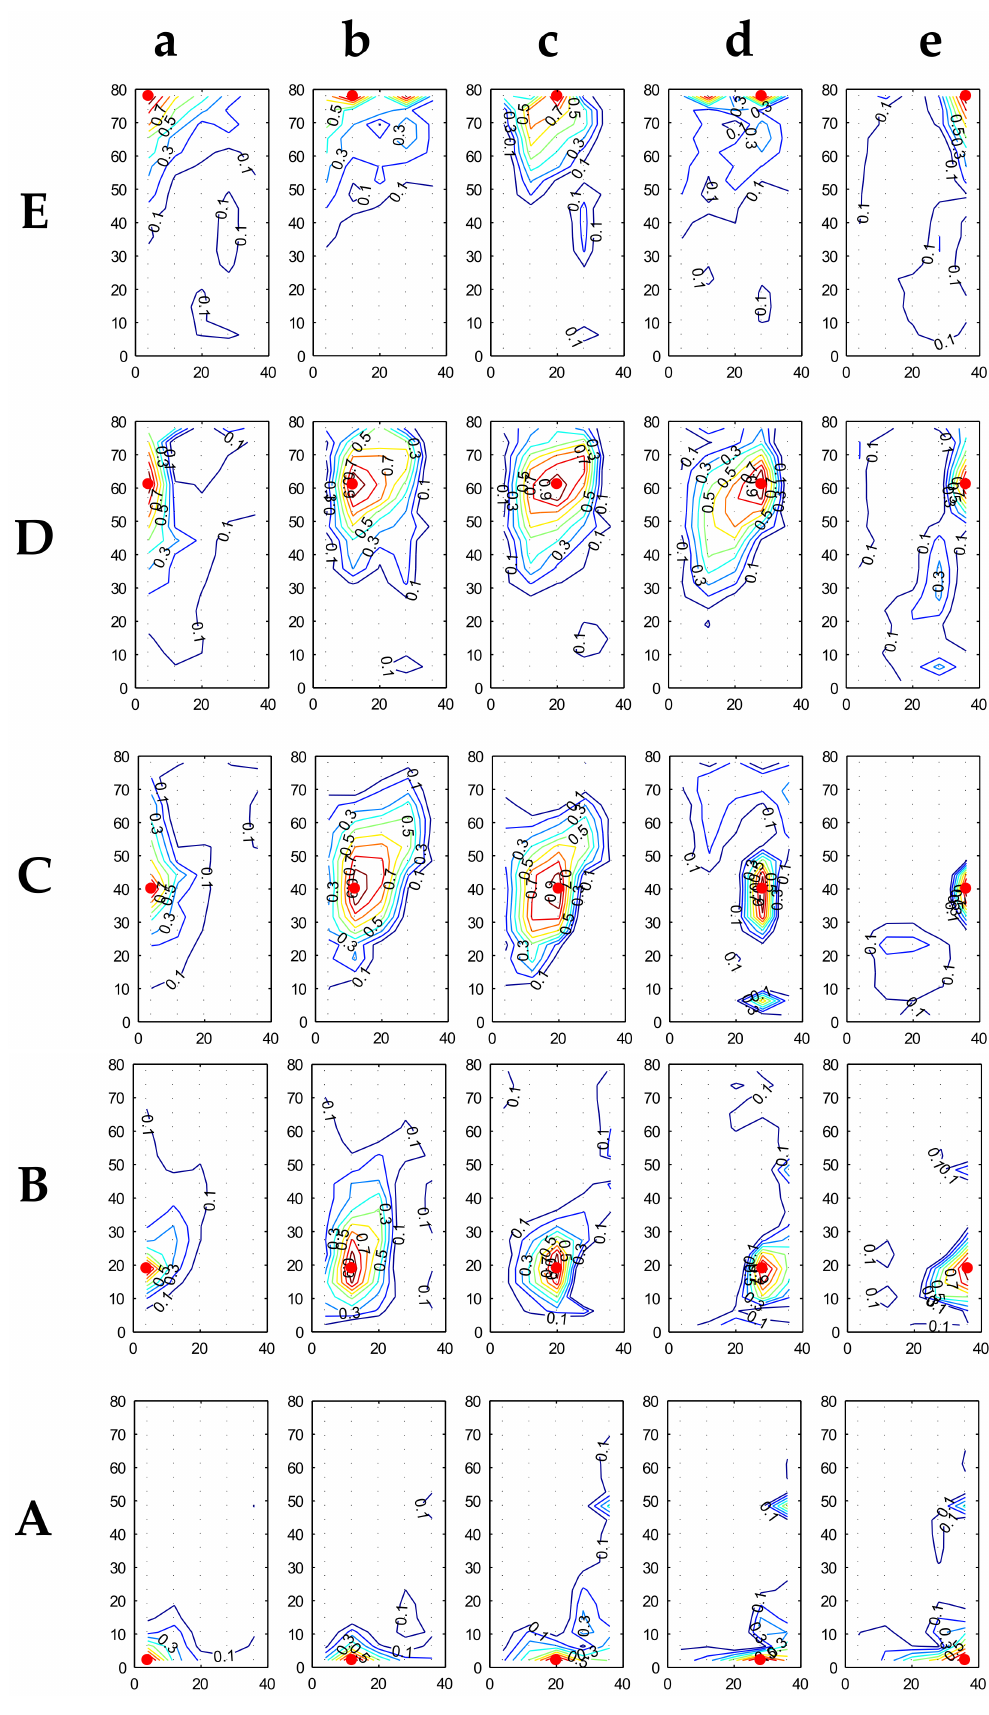
Figure 11. Correlation coefficient trend for RHC at 45 ◦ . Color bar as in Figure